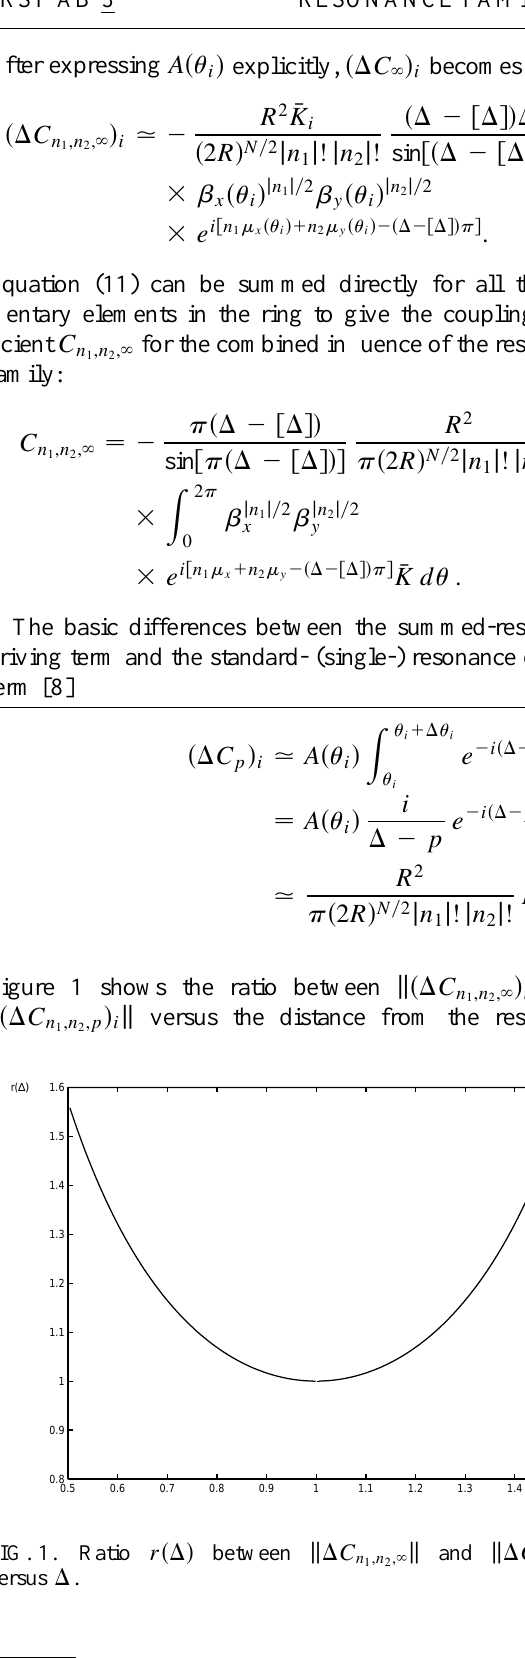
k and k D C 1 , n 2 , `